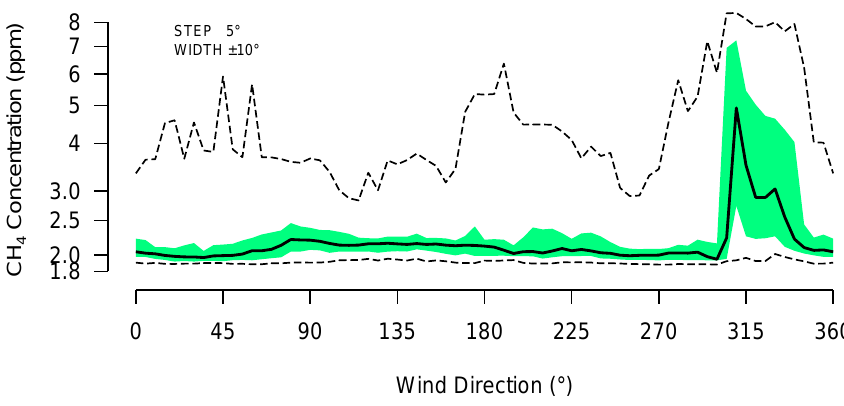
Fig. 3. Ambient CH 4 concentrations as a function of wind direction. The effect of ebullition from the water is clearly seen when winds are from the NW (315 ◦ ), and these high concentrations also influence the maximum values observed when wind arrives from other directions. Data were aggregated for overlapping wind direction sectors of 10 ◦ with 50% overlap. Median (bold line), interquartile range (shaded area; 50% of all values), and maximum and minimum values (dashed lines) are